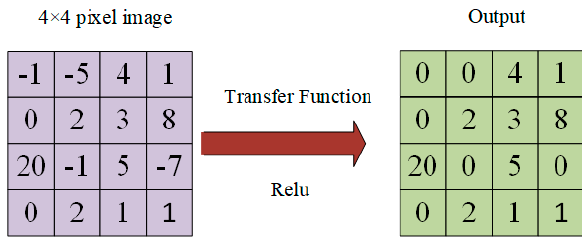
Figure 3. The process of Relu activation function.